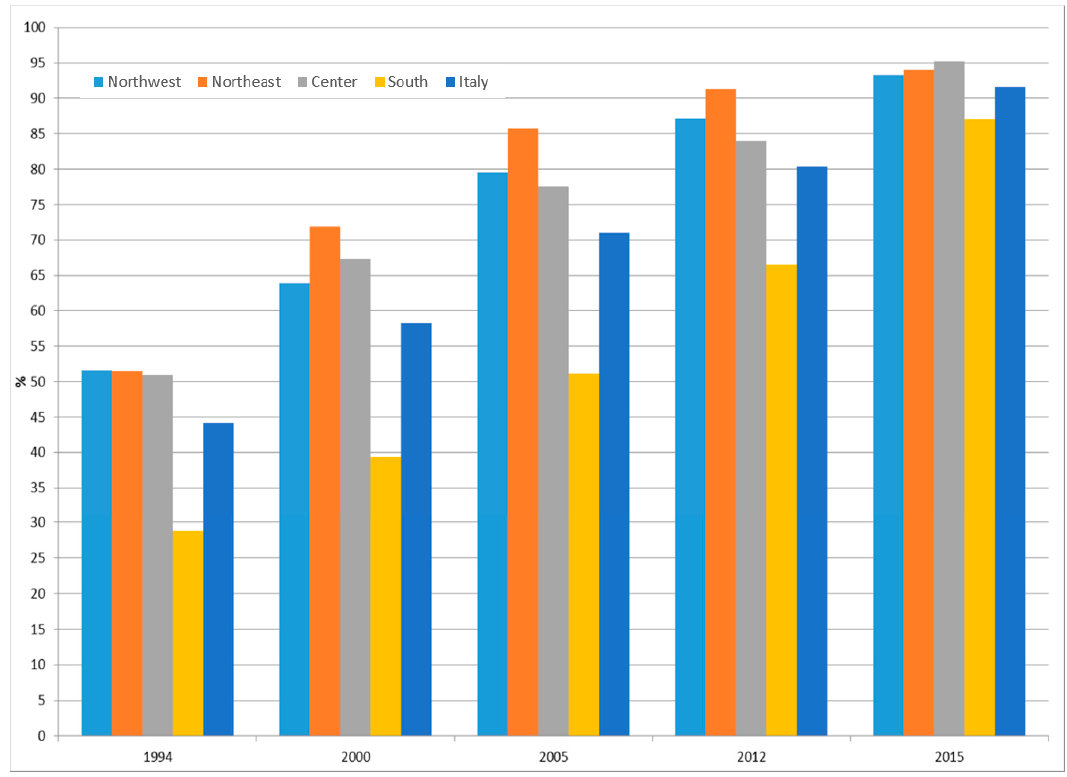
Figure 4. Prevalence of mammography uptake among women of the screening target age (50–69 years old) in Italy overall and by area of residence. Italy, 1994–2015. Source: National Health Interview Survey (NHIS) of the Italian National Institute of Statistics (Istat).